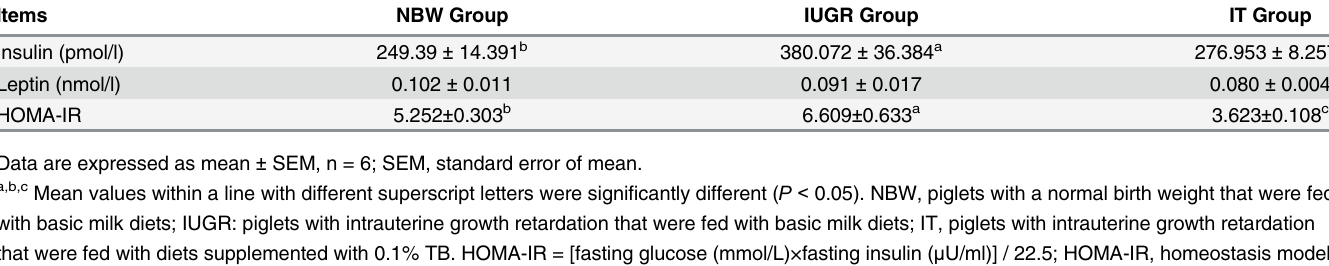
Table 3. Effect of tributyrin (TB) on the concentrations of insulin and leptin in the serum of piglets with intrauterine growth retardation (day 21). Items NBW Group IT Group Insulin (pmol/l) Leptin (nmol/l)